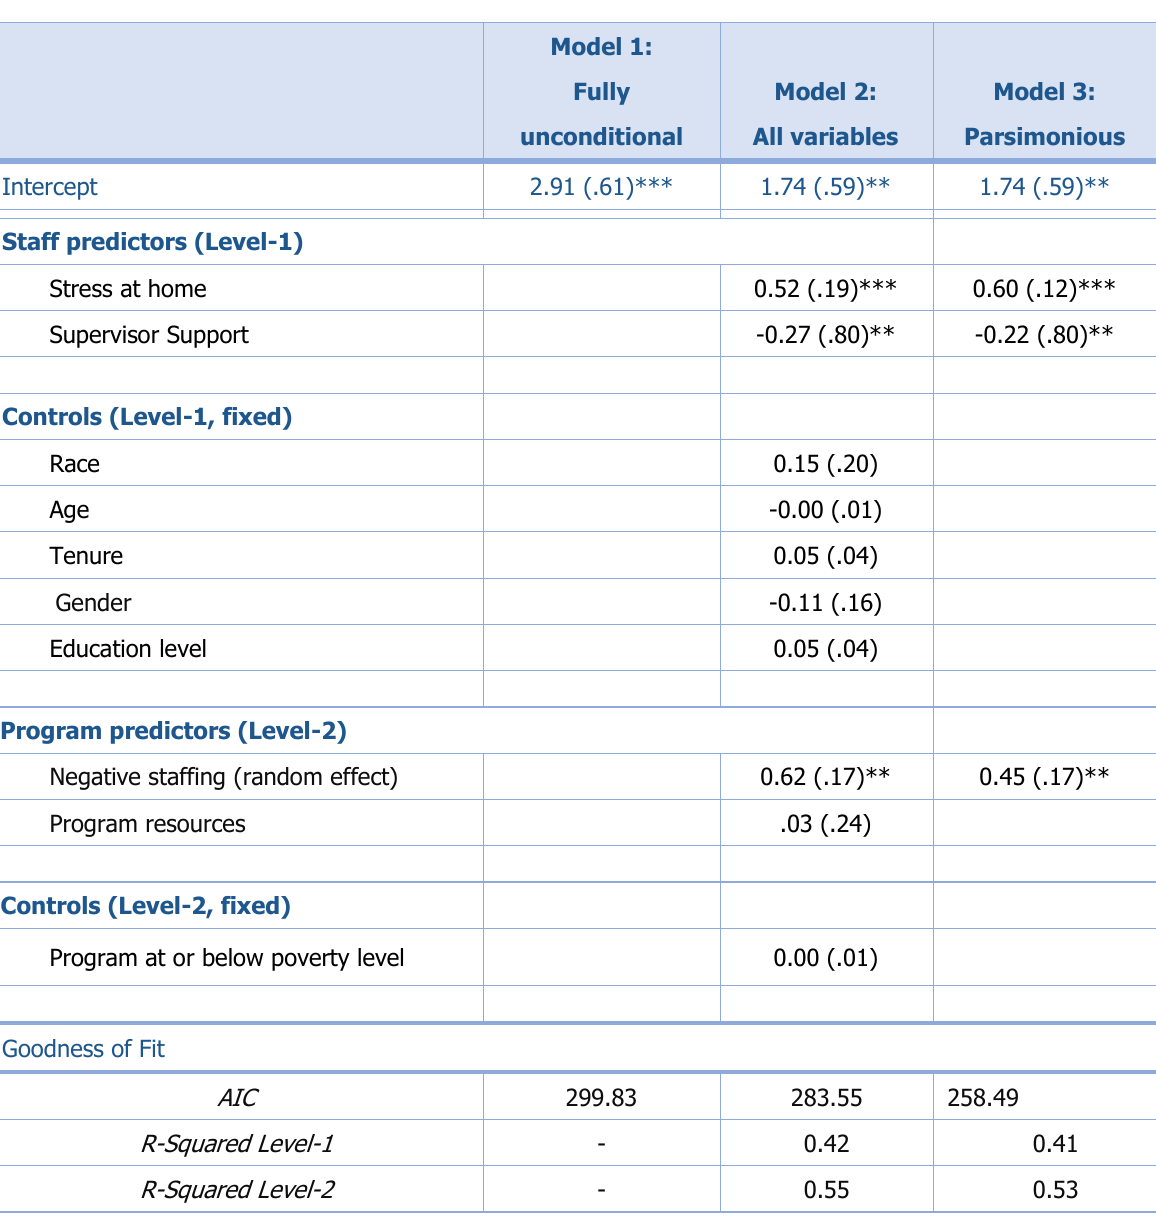
Table B2. Multilevel Models Predictive of Staff